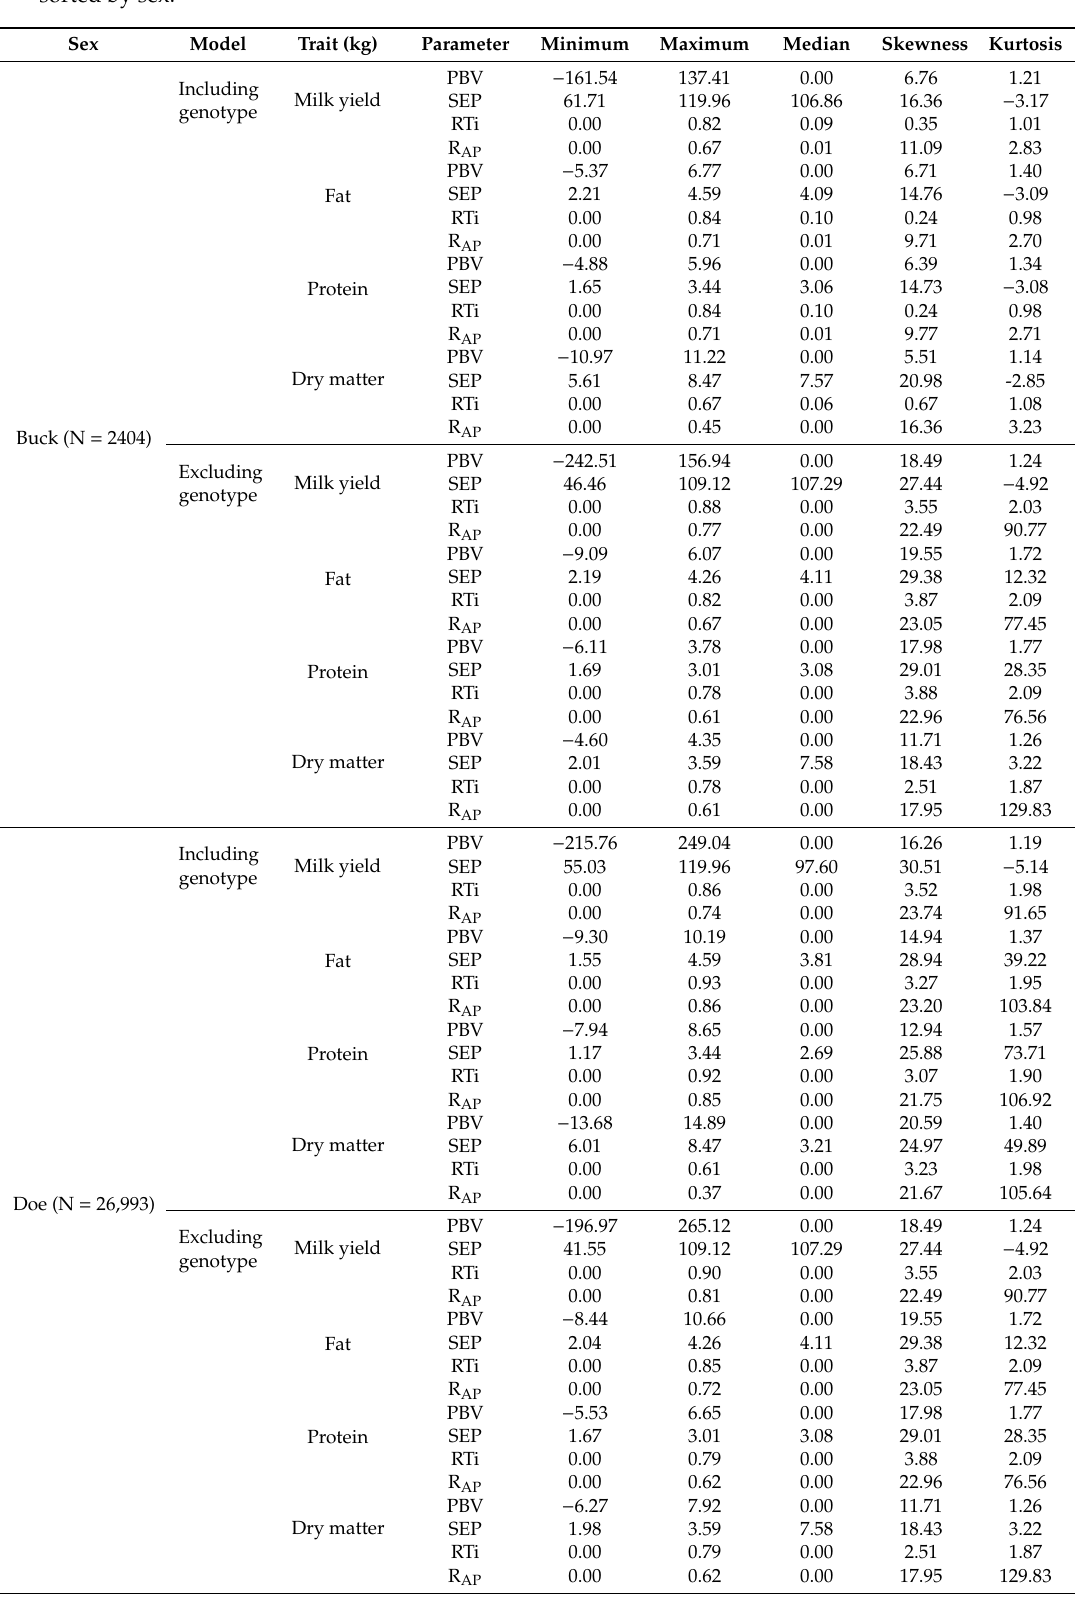
Table 4. Descriptive statistics of predicted breeding values, standard error of prediction (SEP). accuracy (RTi) and reliability (R AP ) for milk yield (kg). protein. fat. and dry matter obtained in bivariate analyses through REML methods in goat milk including and excluding α S1-Casein genotype as a fixed e ff ect sorted by